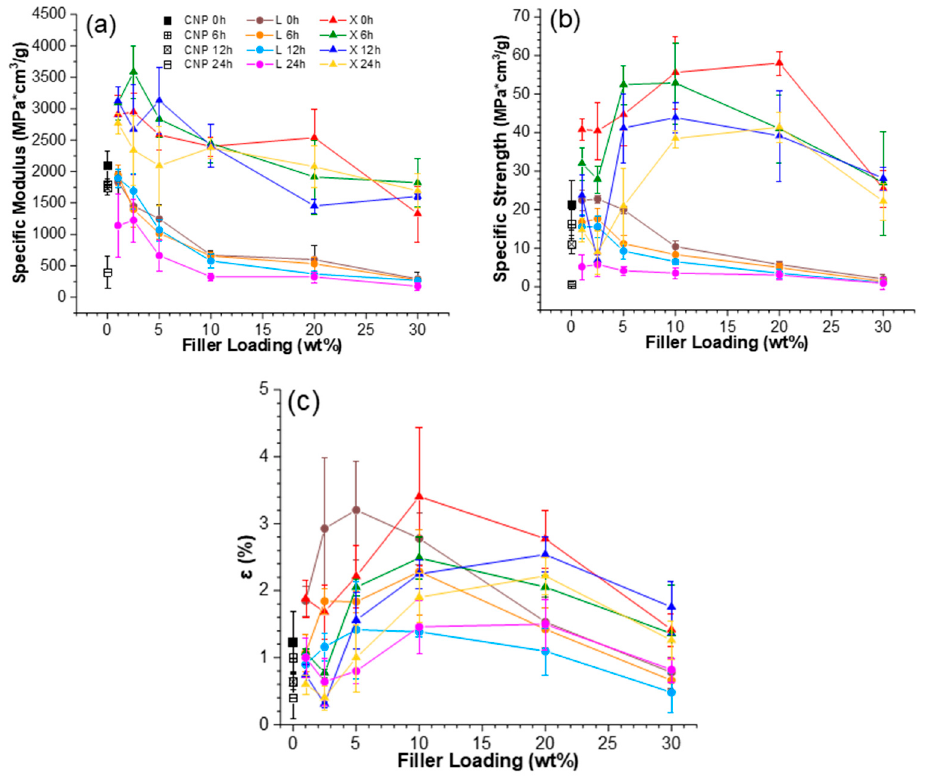
Figure 3. Tensile properties: ( a ) specific elastic modulus, ( b ) specific ultimate tensile strength and ( c ) elongation at break for nanopapers before and after exposure to intensive UV irradiation at 80 °C.